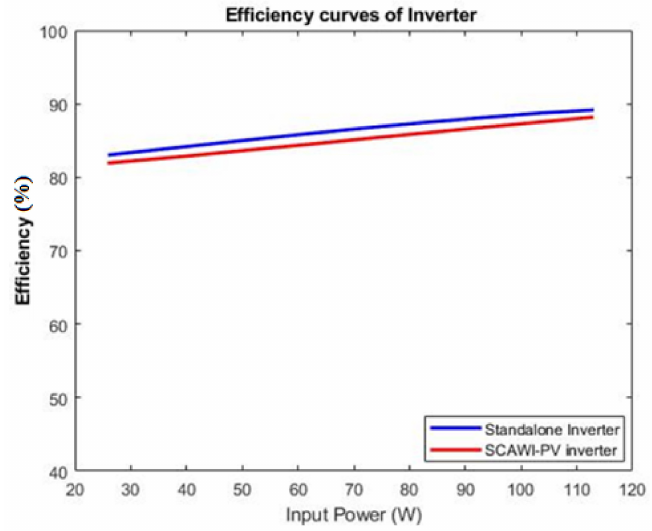
Figure 10. Comparison of end-to-end efficiency of the SCAWI-PV technique and the standalone 12VDC-120VAC inverter.